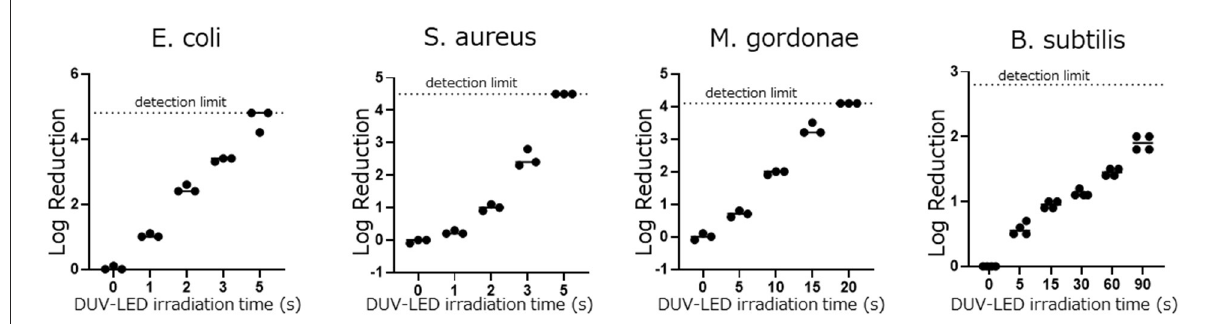
FIGURE2 Differences in the log reduction after DUV-LED irradiation against the plates coated by each bacterial